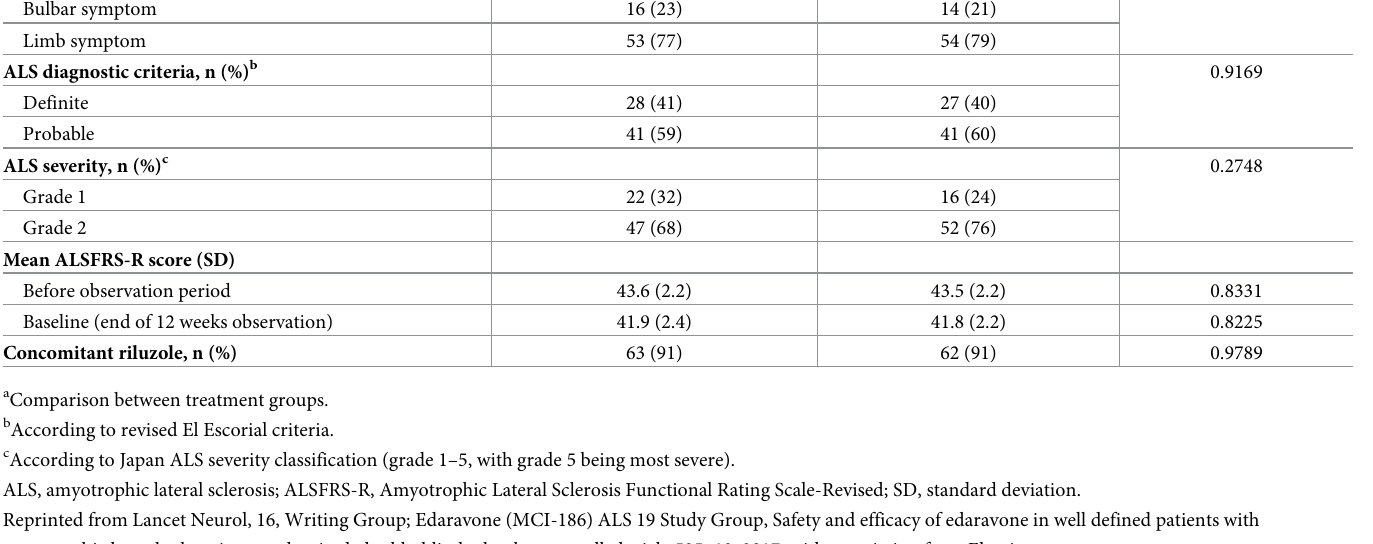
a Comparison between treatment groups.